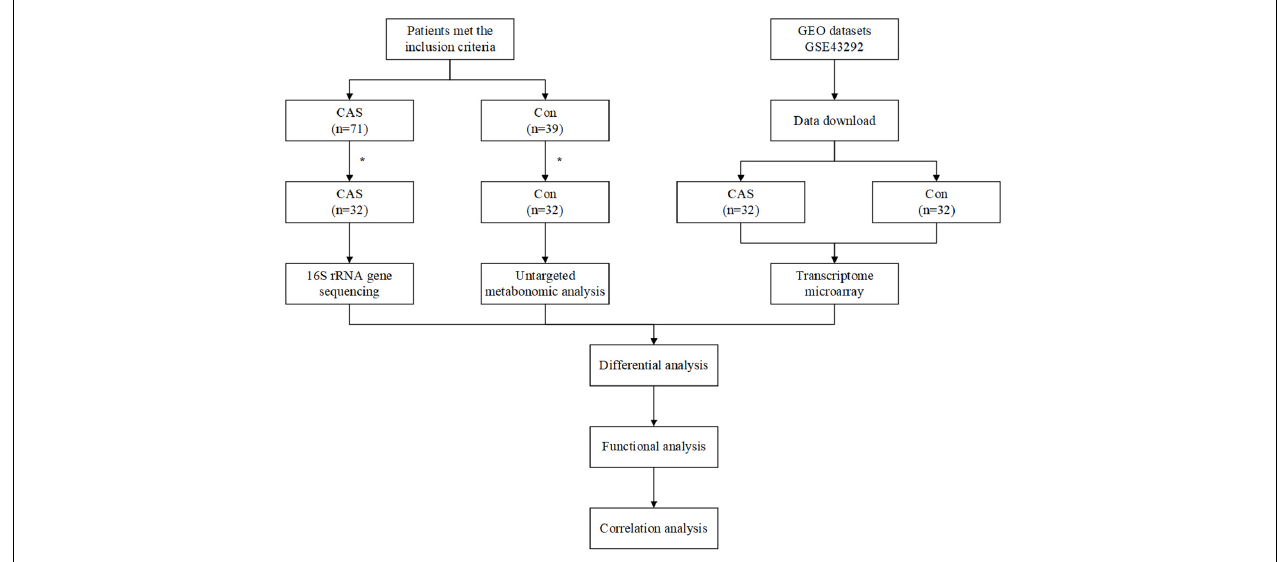
FIGURE 1 | Workflow of our study. *A total of 39 patients were exclude in CAS Group, due to antibiotic usage ( n = 14), probiotic usage ( n = 6), digestive disease ( n = 8), and abdominal surgery ( n = 11). A total of seven healthy controls were excluded due to antibiotic usage ( n = 4), probiotic usage ( n = 2), and abdominal surgery ( n = 1).